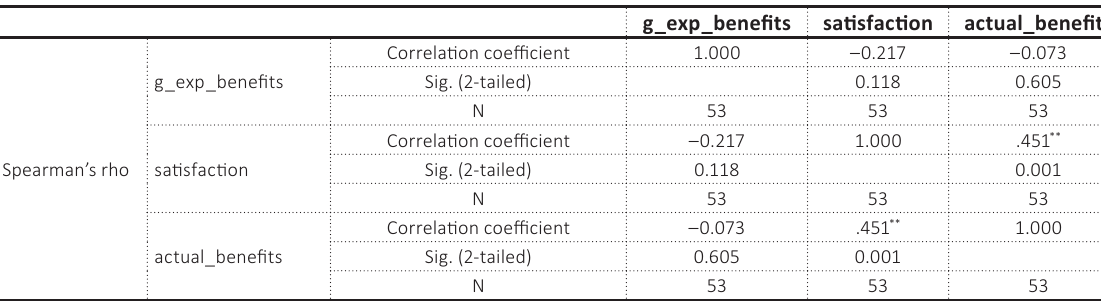
Table 4. Correlations